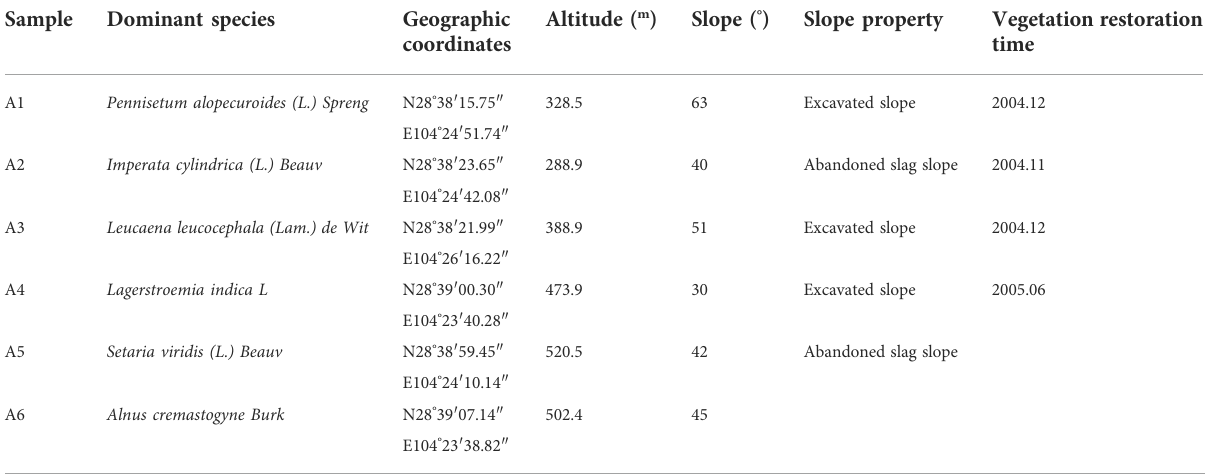
TABLE 1 Basic situation of sample